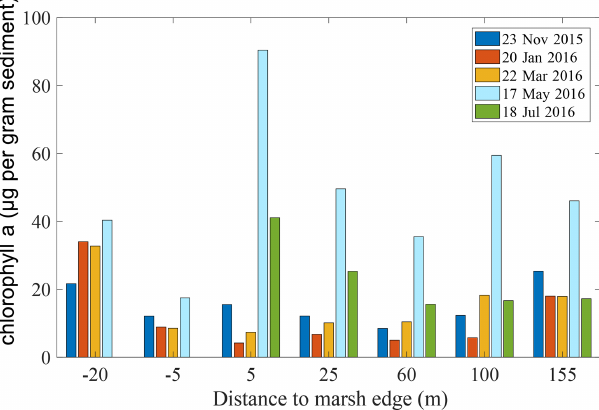
Figure 6. Spatiotemporal variation of the chlorophyll a level in sur- face sediment (top 1cm) at site 2 (Zuidgors